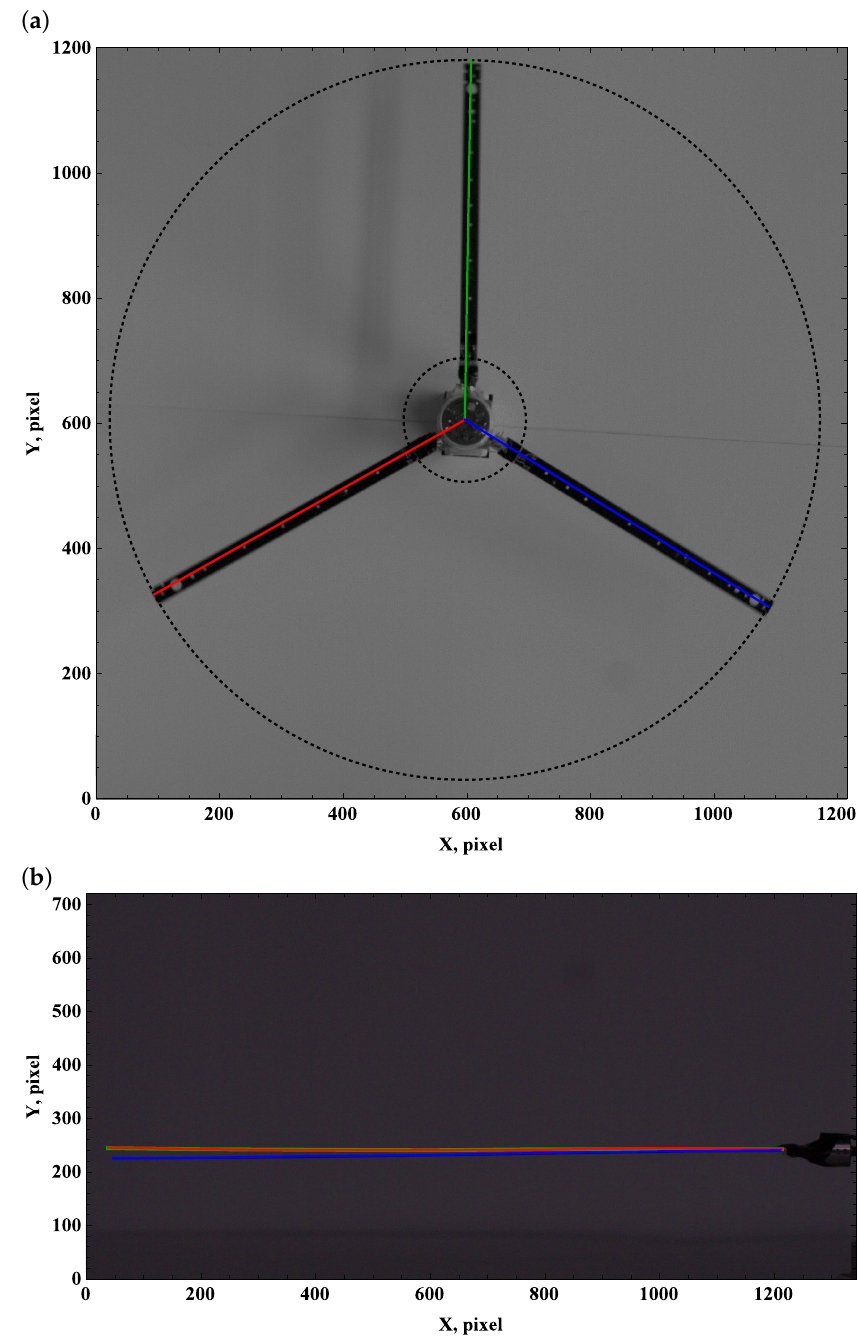
Figure 5. Preset angle 0 ◦ , angular speed 150 rpm: top view ( a ), side view ( b